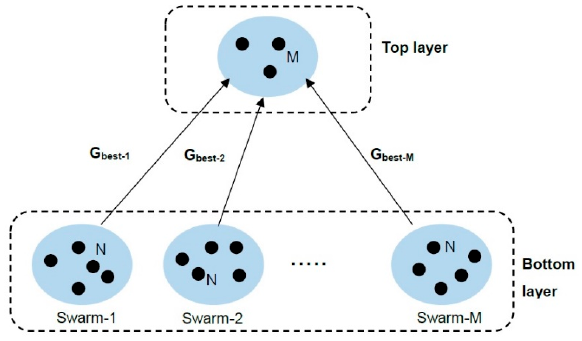
Figure 3. Particle swarm optimization (PSO) block diagram.